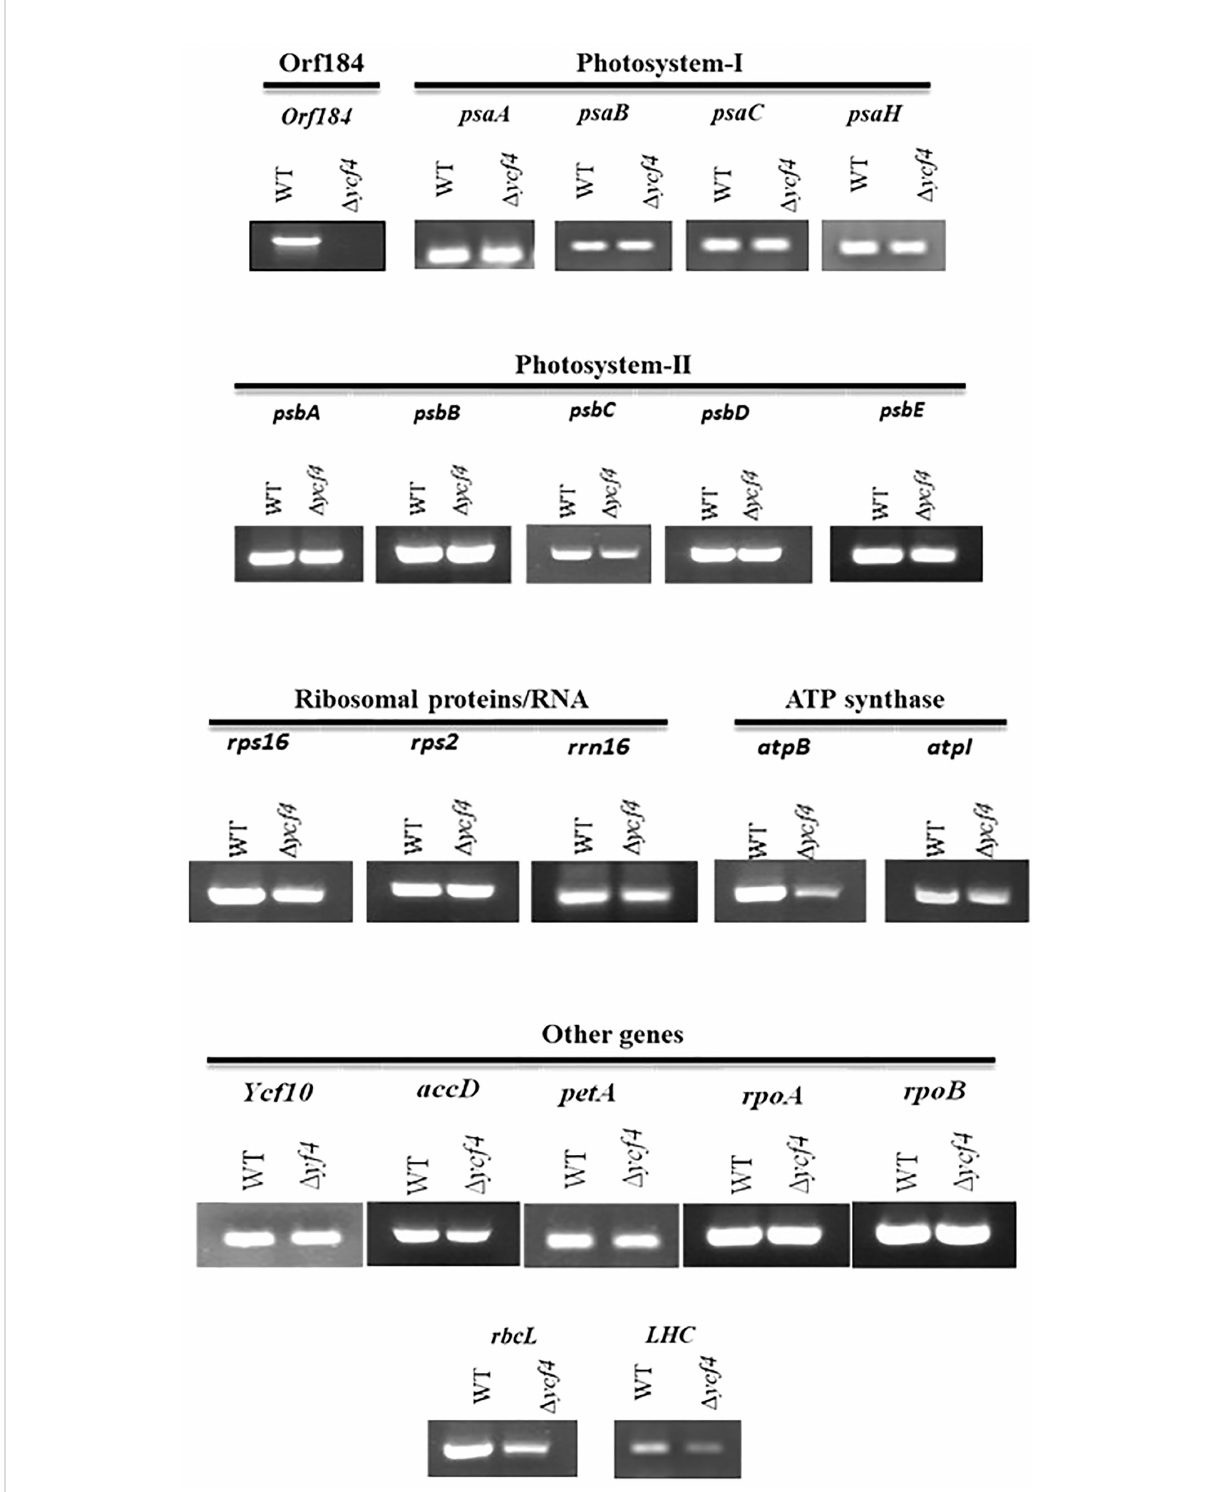
FIGURE 8 Transcript analysis of Δ ycf4 and wild-type tobacco plants. Transcripts show the expression level of genes in both wild-type and Δ ycf4 plants. The expression of various subunits of photosystem-I (psaA, psaB, psaC, psaH) and photosystem-II (psbA, psbB, psbC, psbD, psbE) remained unaltered. The absence of a transcript in Δ ycf4 indicates the puri fi cation of the Δ ycf4 plants to